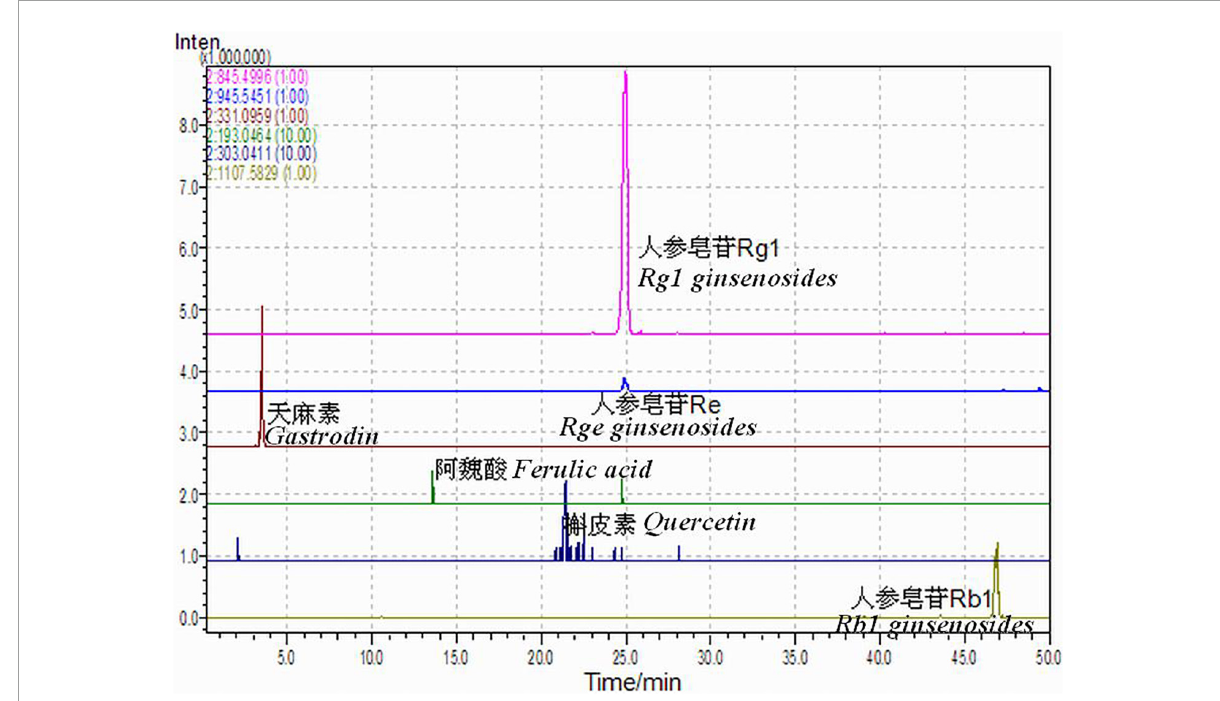
FIGURE3 Shen Ma Yi Zhi granule (SMYZG) sample chromatogram absorption peaks and HPLC retention